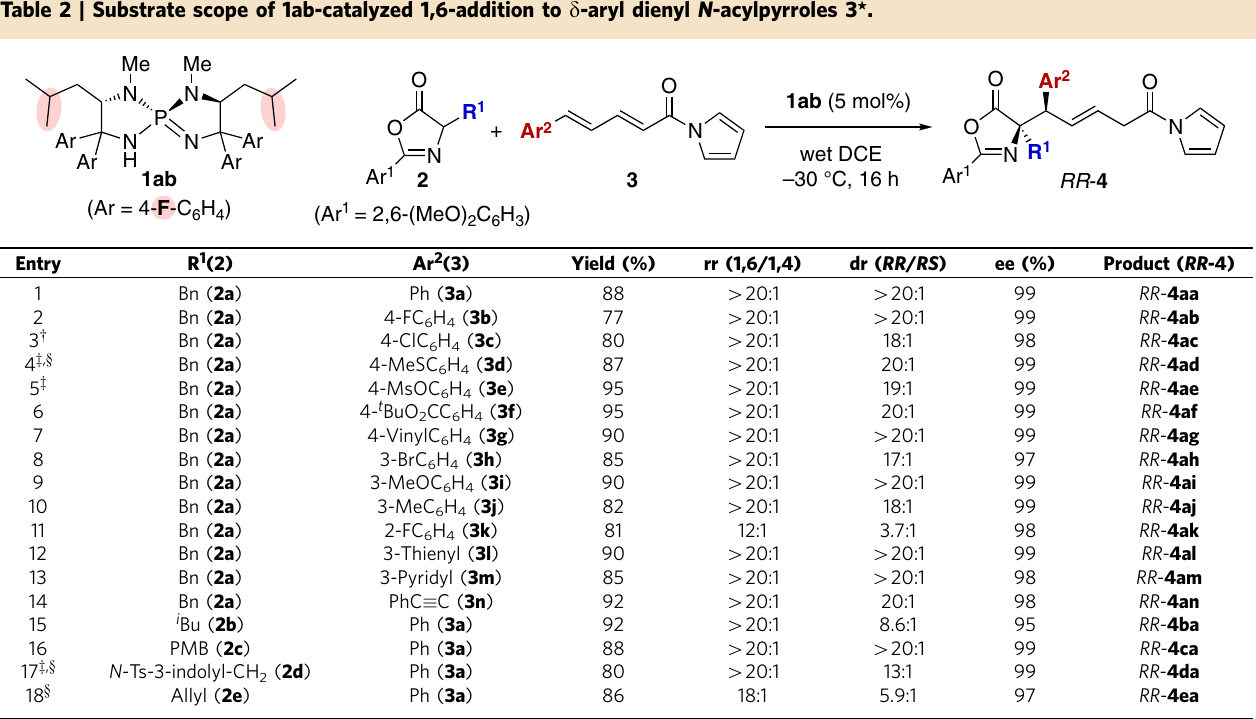
Table 2 | Substrate scope of 1ab-catalyzed 1,6-addition to d -aryl dienyl N -acylpyrroles 3*.